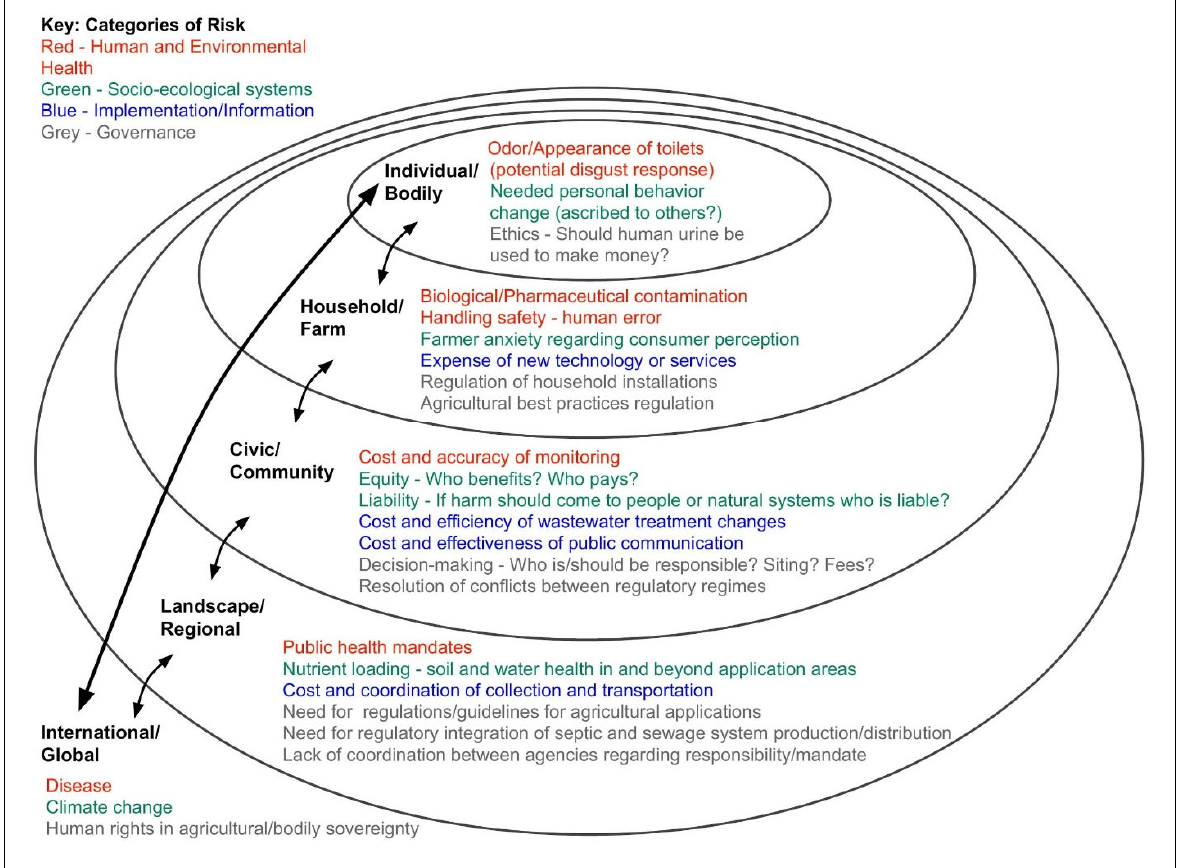
Figure 1. Nested Risks and Responsibilities Identified by Participants Graphic representation of the nested risks revealed by our research, in concentric circles that correspond to the scales at which risks exist and/or are experienced by respondents. The color coding represents different types of risk at each scale, as they connect to and drive or inform one another. These range from human and environmental health (red), to those concerning complex environmental and social systems (green), to those related to implementation and information needs (blue), and finally considerations of governance and regulatory factors (grey). Of course, by “scale” we mean to include the permeability of these boundaries and the new relationships created among people and across differing scales (see Sayre,